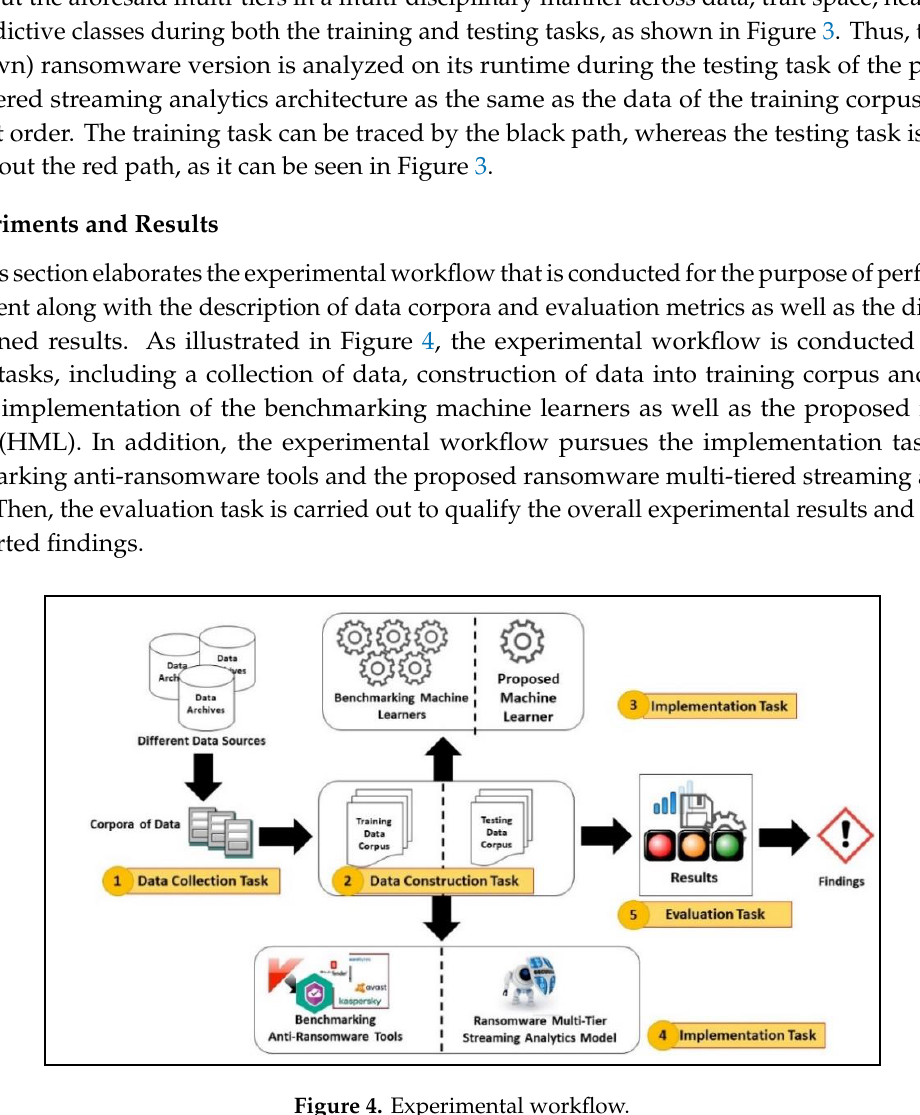
Figure 3. Structure of multi-tier ransomware streaming analytics model.